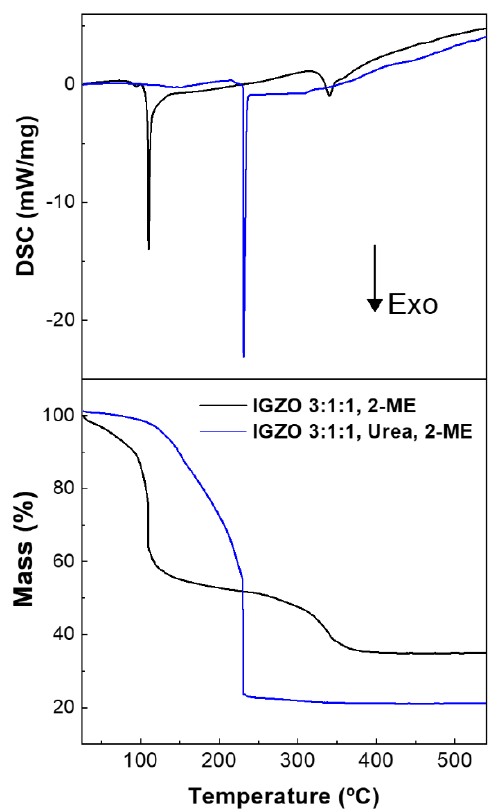
Figure 1. Differential scanning calorimetry (DSC)-thermogravimetry (TG) analysis of the IGZO Figure 1. Di ff erential scanning calorimetry (DSC)-thermogravimetry (TG) analysis of the IGZO (3:1:1) (3:1:1) precursor solution with 2-ME as solvent and using with or without urea as fuel. precursor solution with 2-ME as solvent and using with or without urea as